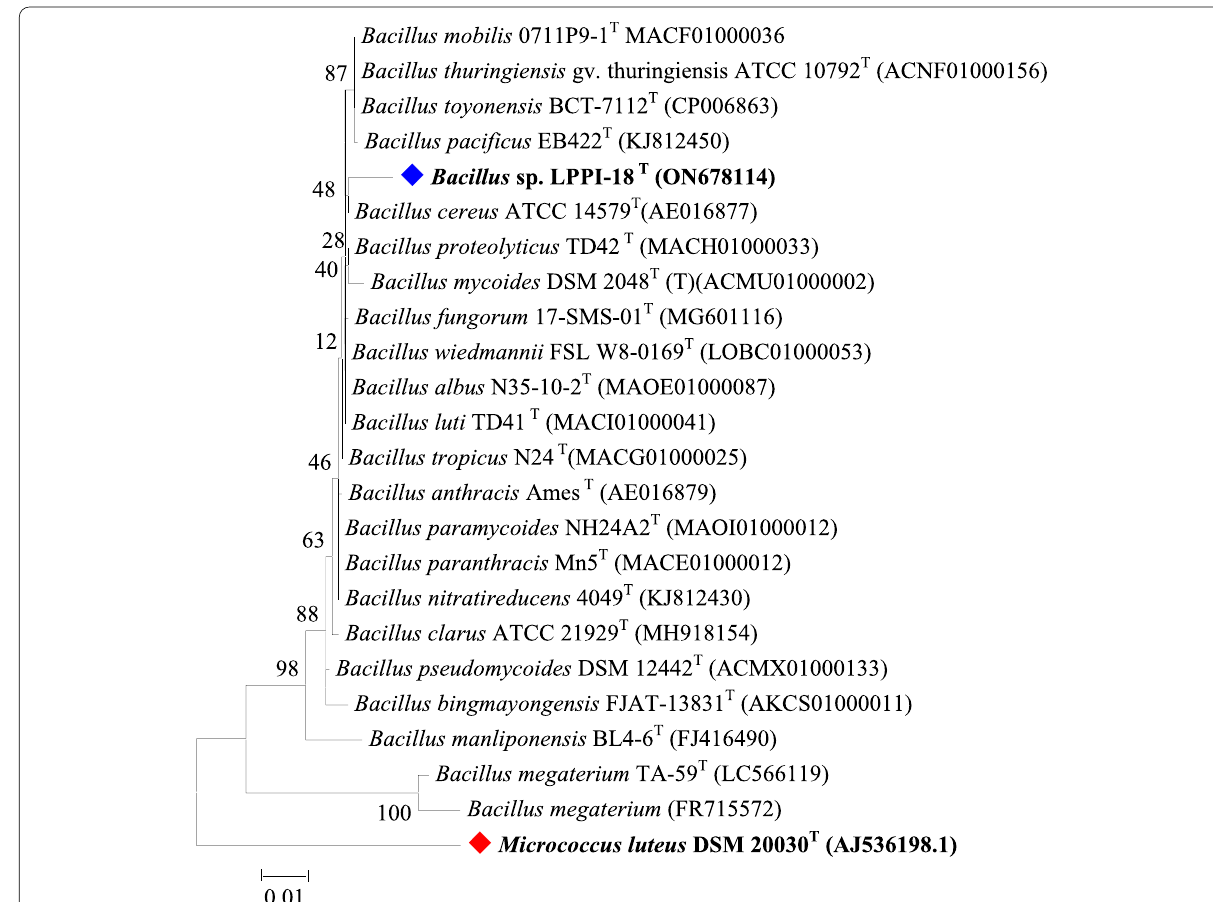
Fig. 4 Evolutionary relationships of taxa and phylogenetic tree for 16S rRNA gene sequences of PHA-producing Bacillus sp. LPPI-18 (ON678114). The evolutionary history was inferred by using the maximum likelihood method based on the Kimura 2-parameter model [27]. The tree with the highest log likelihood is shown. The percentage of trees in which the associated taxa clustered together is shown next to the branches. Initial tree(s) for the heuristic search were obtained automatically by applying neighbor-joining and BioNJ algorithms to a matrix of pairwise distances estimated using the maximum composite likelihood (MCL) approach, and then selecting the topology with superior log likelihood value. The tree is drawn to scale, with branch lengths measured in the number of substitutions per site. The analysis involved 24 nucleotide sequences. Selected codon positions were 1st 2nd 3rd Noncoding. All positions with less than 95% site coverage were eliminated. That is, fewer than 5% alignment gaps, missing + + + data, and ambiguous bases were allowed at any position. There were a total of 1384 positions in the final dataset. Evolutionary analyses were conducted in MEGA 7.0.21 [28]. The replication of confidence values was 1000 bootstrap (percentage of 1000 replication). Bar, 0.01 substitutions per nucleotide position. Micrococcus luteus DSM 20030 T (AJ536198.1) was designated and used as outgroup in the analyses; other related sequences were obtained from EzTaxon-e